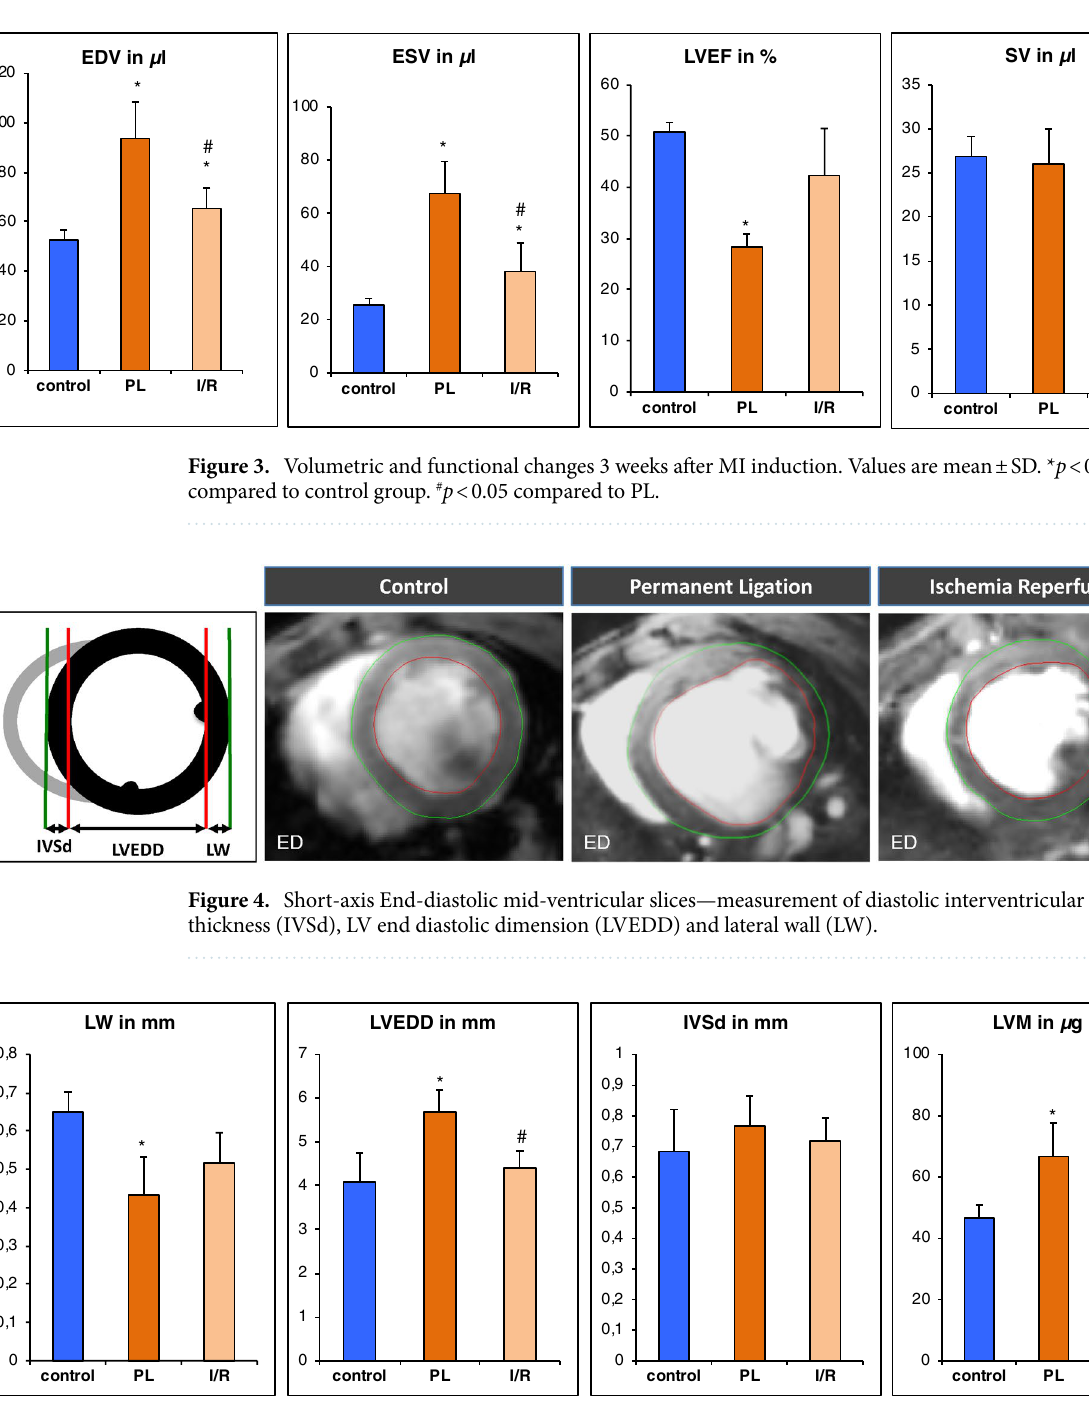
Figure 5. Short-axis end-diastolic dimensions and left ventricular mass. Values are mean ± SD. * p < 0.05 compared to control group. # p < 0.05 compared to